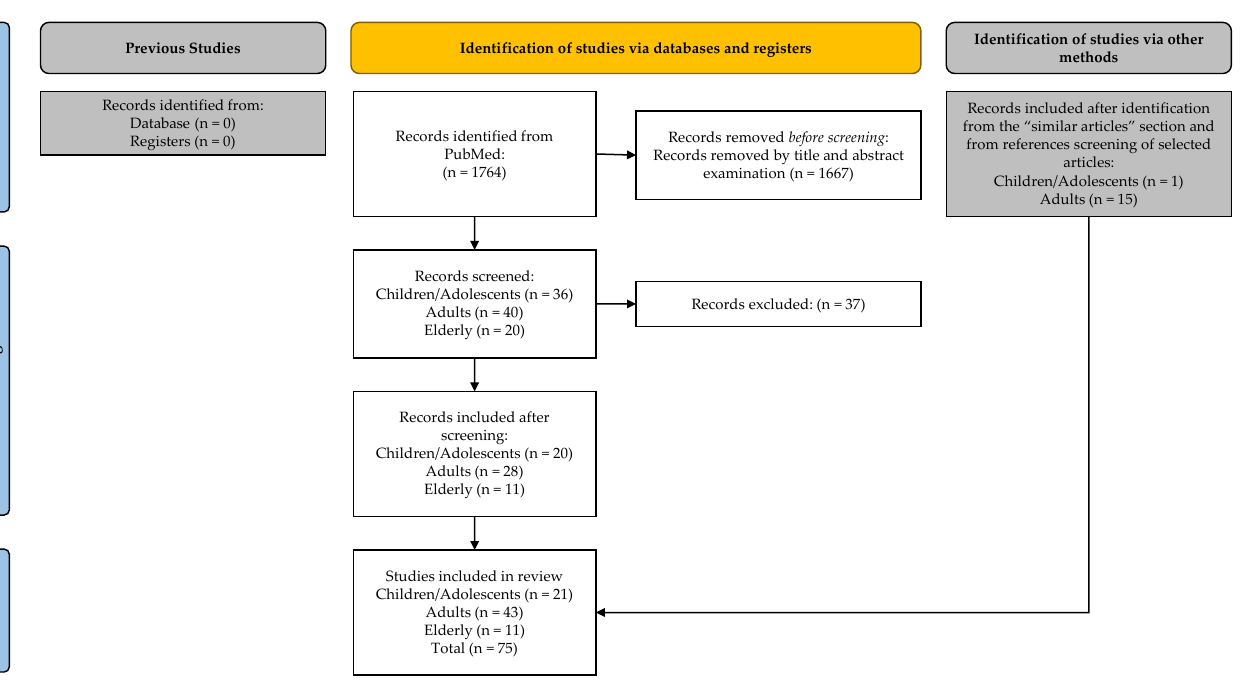
Figure 1. Flowchart of the study selection